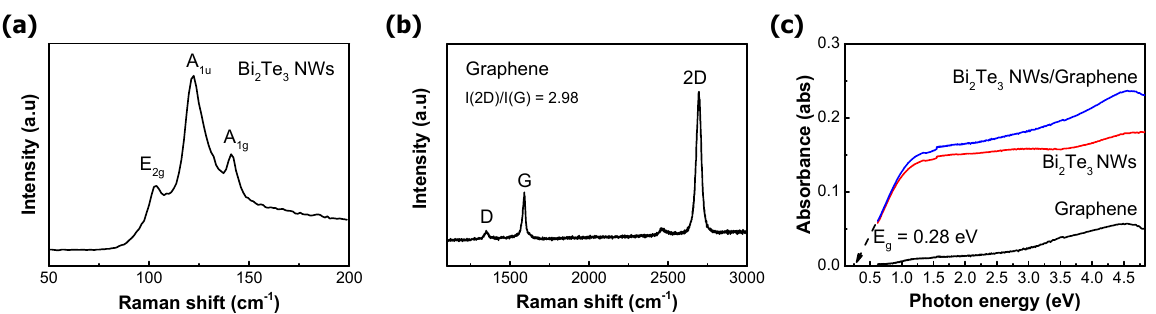
Figure 2. Raman spectroscopic measurements of ( a ) Bi 2 Te 3 NWs and ( b ) graphene, and ( c ) UV-Vis absorption spectroscopy of each stack.